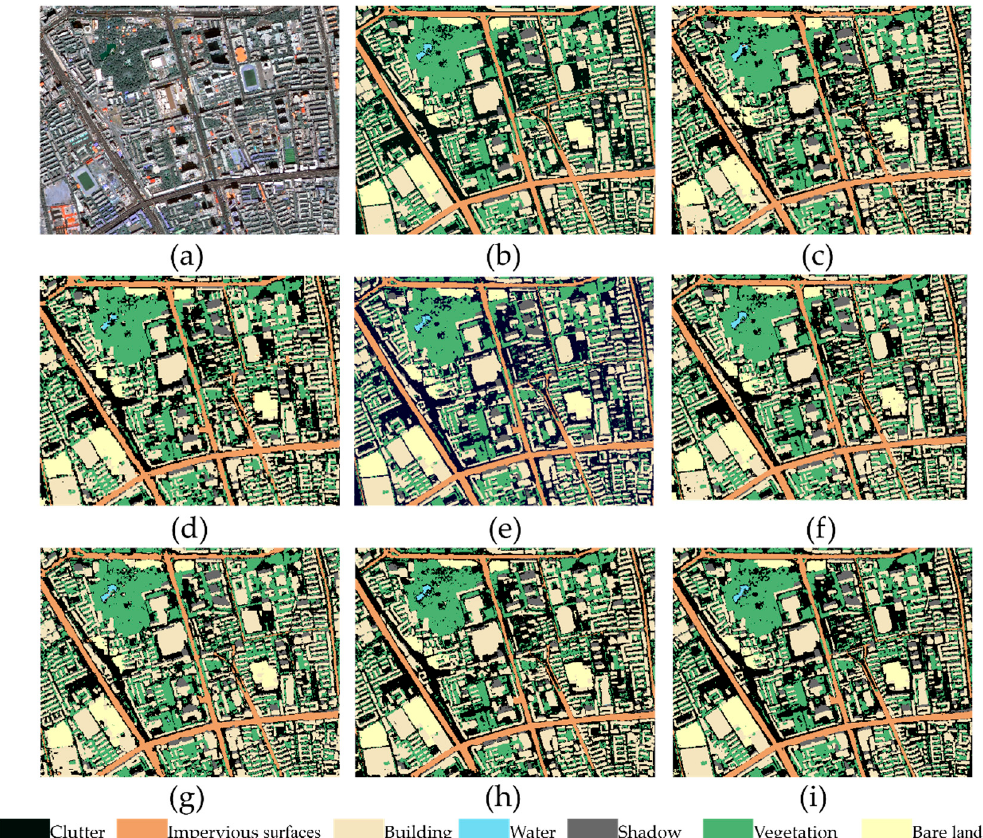
Figure 5. The segmentation results of different methods on the Gaofen-2 test data set. ( a ) Original image, ( b ) ground truth, ( c ) SegNet, ( d ) FCN8s, ( e ) U-Net, ( f ) Deeplabv3+, ( g ) Inceptionv3, ( h ) Res-U-Net, and ( i ) Multi-U-Net.